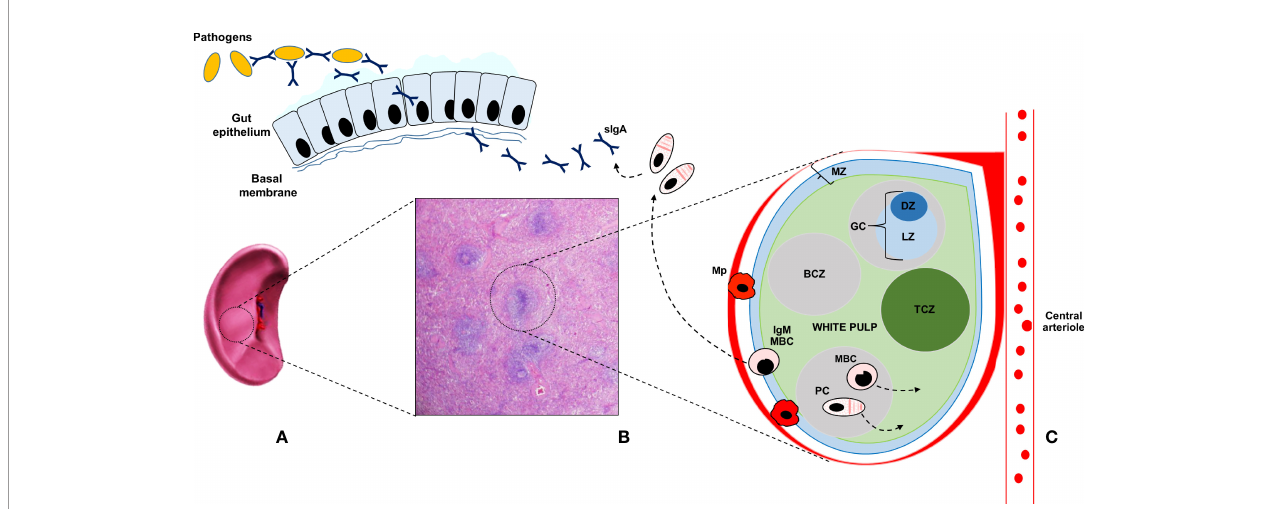
FIGURE 1 | The human splenic is depicted in (A) ; whereas its histologic appearance is shown in (B) The main part of the splenic tissue is the red pulp, whereas the white pulp represents less than 25 percent of the volume. Antigens reach the spleen only through the blood stream, via the splenic artery (not depicted for clarity), since the spleen lacks lymphatic vessels. The white pulp is made up of multiple lymph node-like regions, which are embedded in the red pulp, without a capsule. In (C) the ultrastructure of the white pulp is represented. The white pulp is surrounded by a layer of innate cells, like specialized macrophages subsets (Mp), making up the marginal zone (MZ) in mice and the perifollicular zone in humans. Bridges channels connecting the red and white pulp are not shown for clarity. Within the white pulp, different compartments can be identi fi ed, such as the B cell zone (BCZ) and the T cell zone (TCZ), which in humans is also called periarteriolar lymphoid sheath (PALS). In the BCL, germinal centers (GC) are found. They comprise a dark zone (DZ) and a light zone (LZ). In the DZ, B cells undergo cell division and somatic hypermutation; in the LZ, B cells with productive rearrangements in their B cell receptor, present antigens to T cells and differentiate into memory B cells (MBC) and plasma cells (PC), during germinal center reactions. MBC display migratory features to the extrafollicular areas of the spleen, as suggested by the arrow, and reach lymph nodes via the blood. After antigen encounter, MBC give rise to antibody-secreting PC. MBC can also re-enter the GC to acquire increased af fi nity for the antigen. PC preferentially migrate to the bone marrow, where they constitutively secrete antibodies with a precise speci fi city. GC- and T- cell independent reactions are also depicted. IgM memory cells (IgM-MBC) arise outside GC, mainly in the MZ. In humans, IgM-MBC are migratory; their traf fi cking to the gut epithelium is suggested by means of a dashed arrow. In the gut, IgM MBC give rise to IgA-secreting PC, which mediate mucosal immune responses against bacteria and viruses, through the production and delivery up to the intestinal lumen of secretory IgA